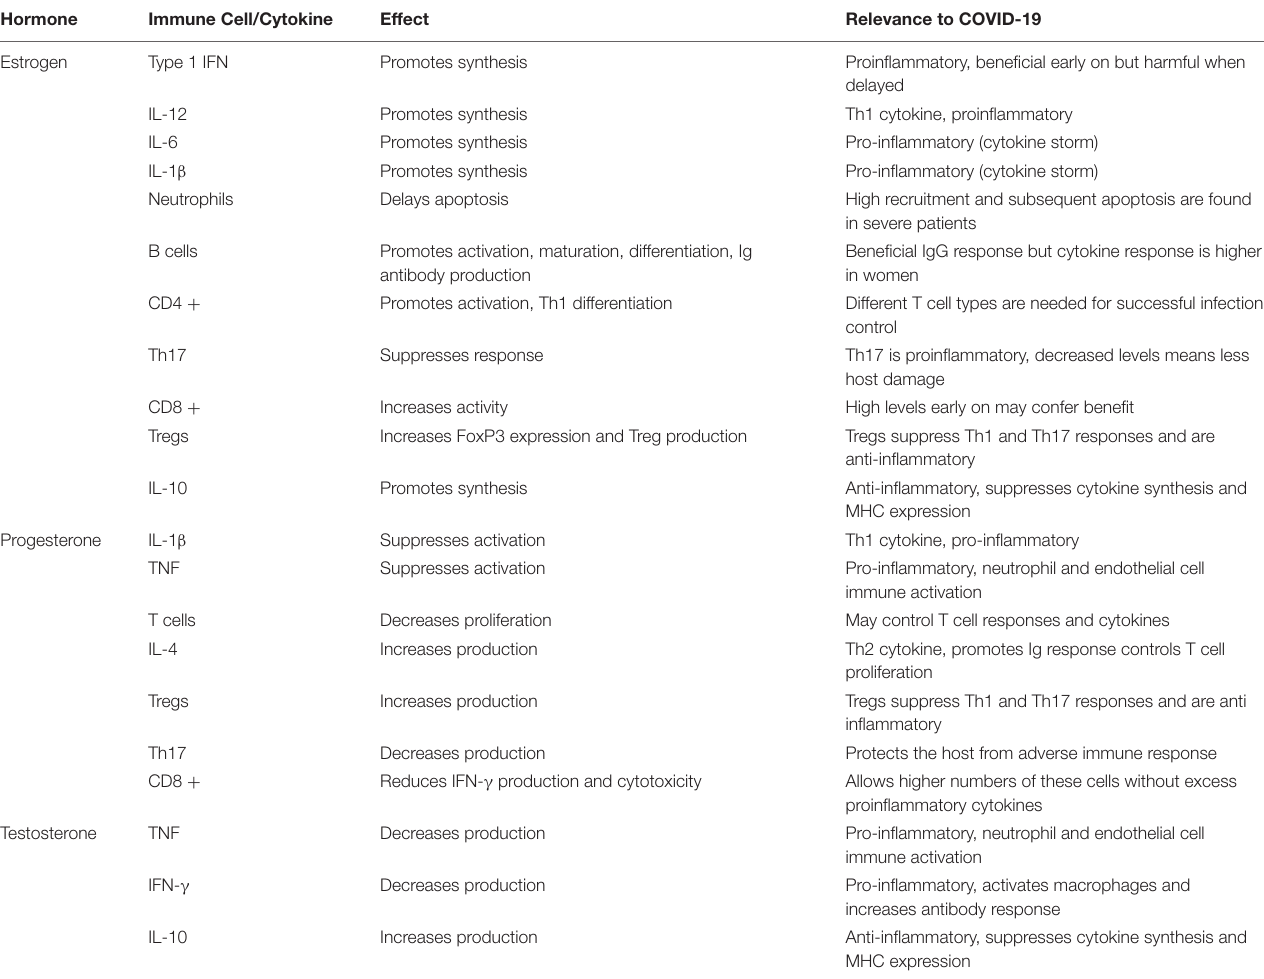
TABLE 2 | Sex Hormones and their effects on immunity and relevance to COVID-19. Hormone Immune